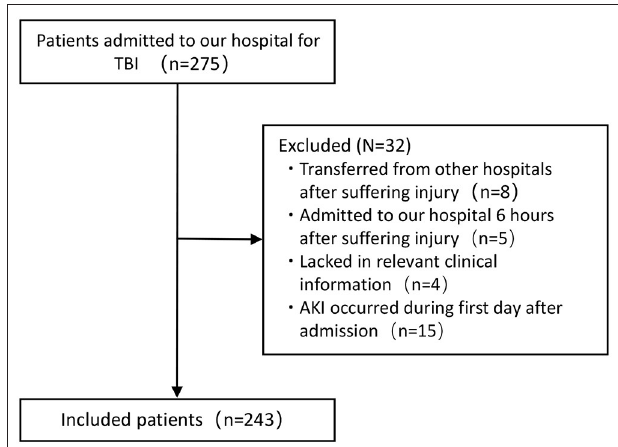
FIGURE 1 | Flowchart of patients